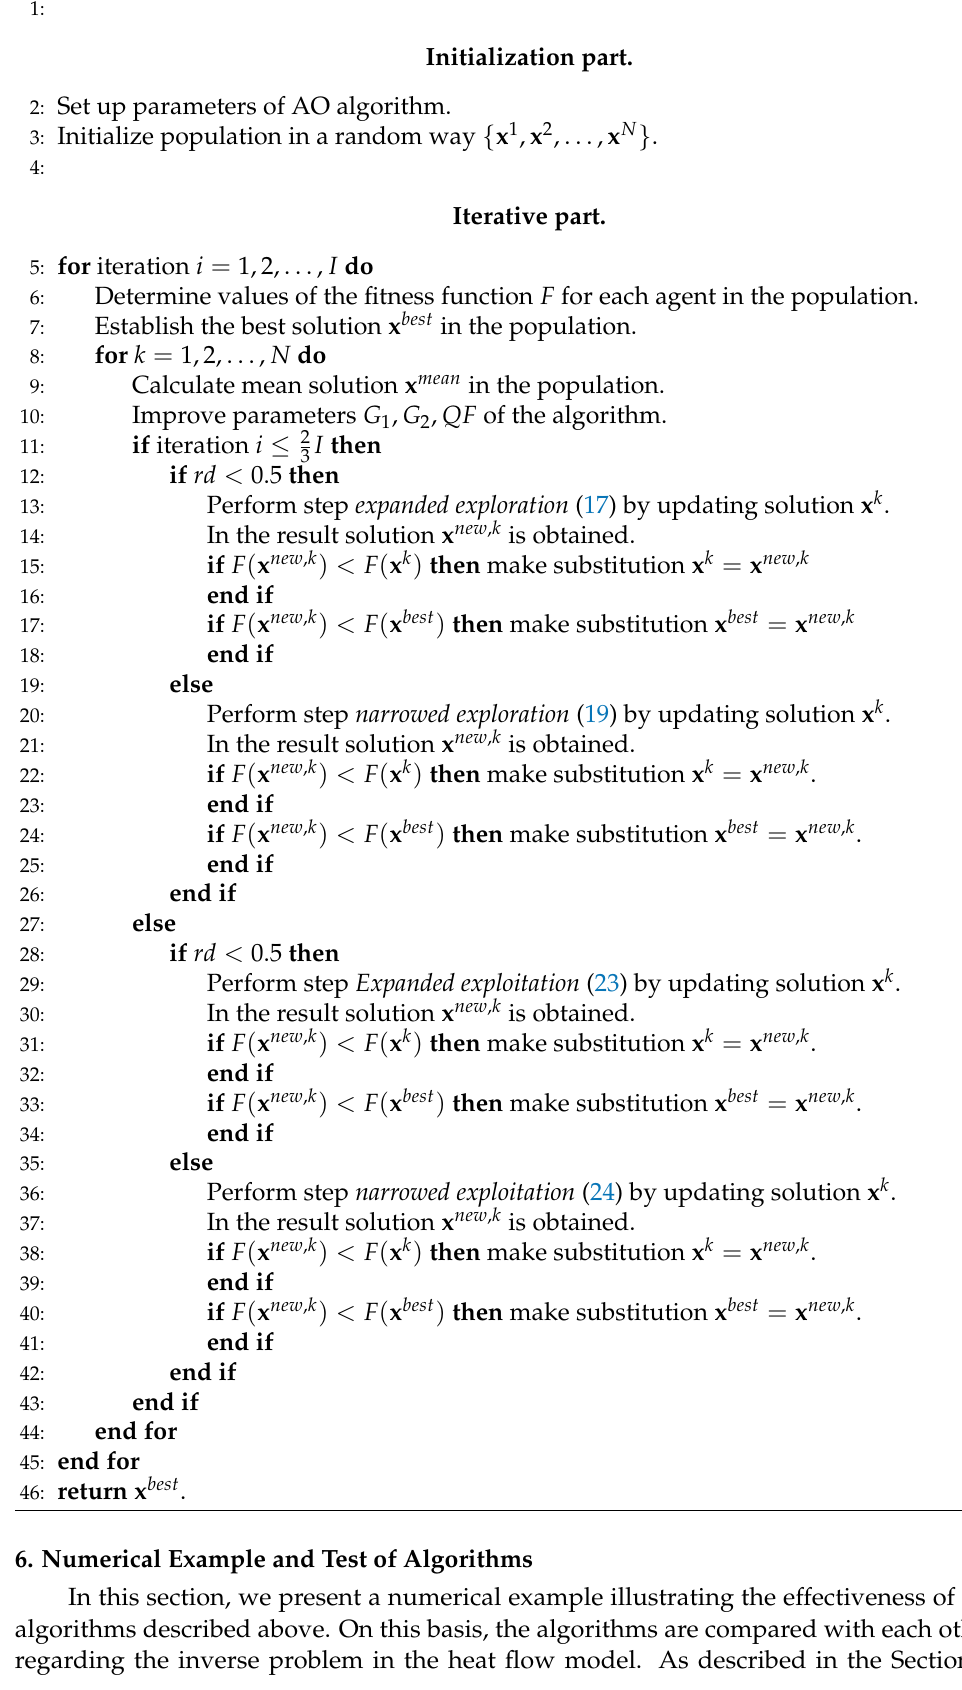
Algorithm 4 Pseudocode of